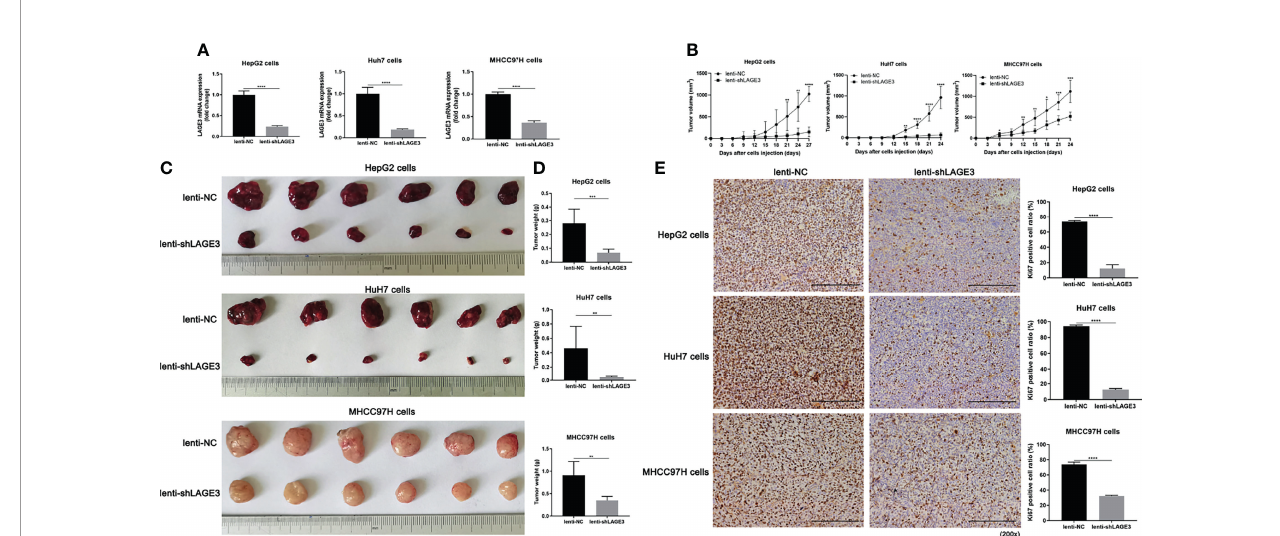
FIGURE 10 | LAGE3 knockdown attenuates the tumorigenicity of HCC cell lines in vivo . (A) mRNA expression of LAGE3 in HepG2, HuH7 and MHCC97H cells transfected with lenti-NC or lenti-shLAGE3. (B) Growth curves of xenograft tumors in nude mice of lenti-NC groups and lenti-shLAGE3 groups. The tumor volume was calculated using the formula: V = L×W 2 /2 (L = tumor length, W = tumor width). (C) Images of HepG2, HuH7 and MHCC97H xenograft tumors in nude mice of lenti-NC groups and lenti-shLAGE3 groups. (D) Comparison of the tumor weight between lenti-NC groups and lenti-shLAGE3 groups. (E) Immunohistochemical staining of Ki67 in xenograft tumor tissues from lenti-NC groups and lenti-shLAGE3 groups. All of the data are expressed as mean ± SD. n = 6 for BALB/c-nu nude mice following each treatment per experimental xenograft. * P < 0.05, ** P < 0.01, *** P < 0.001 and **** P < 0.0001 compared with lenti-NC